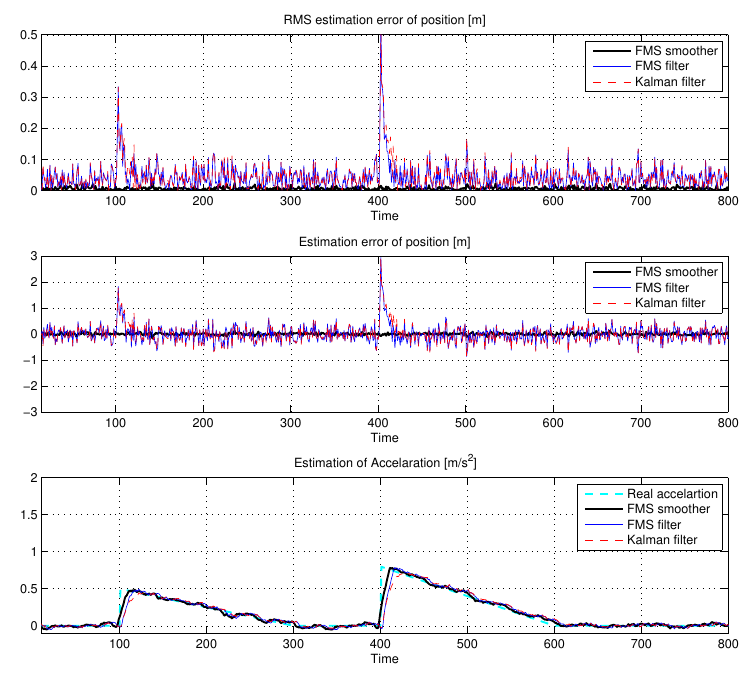
Figure 2. Simulation result for suddenly changing acceleration(ramp-type).